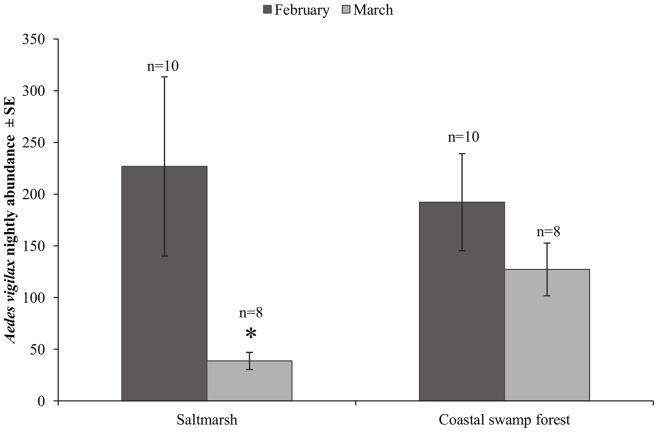
Nightly Aedes vigilax abundance.Mean nightly abundance of the Ae. vigilax in saltmarsh and coastal swamp forest during February 2010 and March 2010. * Indicates interaction effect.